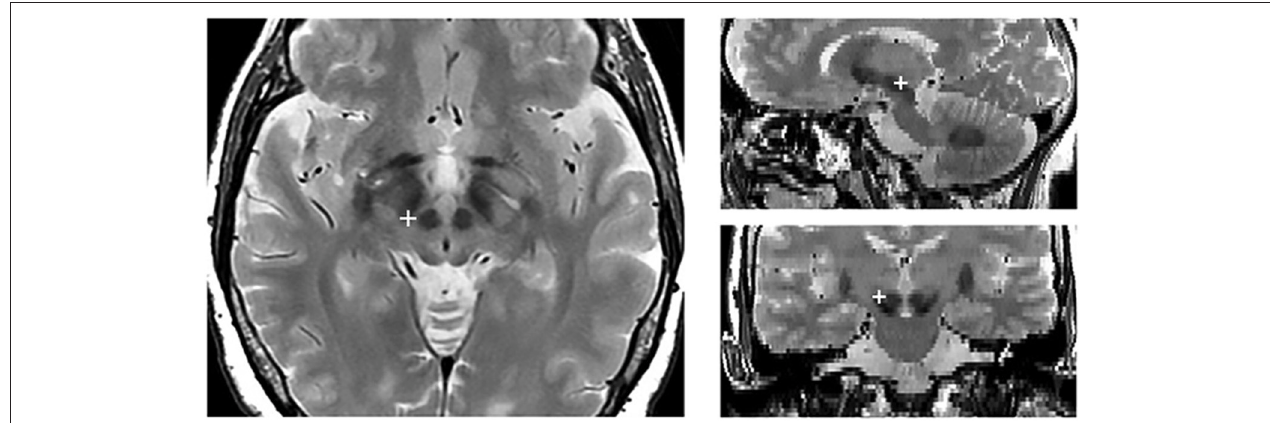
FIGURE 1 | Localization of the active electrode contact in an example subject. The red cross indicates the position of the active contact in the axial (right), sagittal (upper left), and coronal (lower